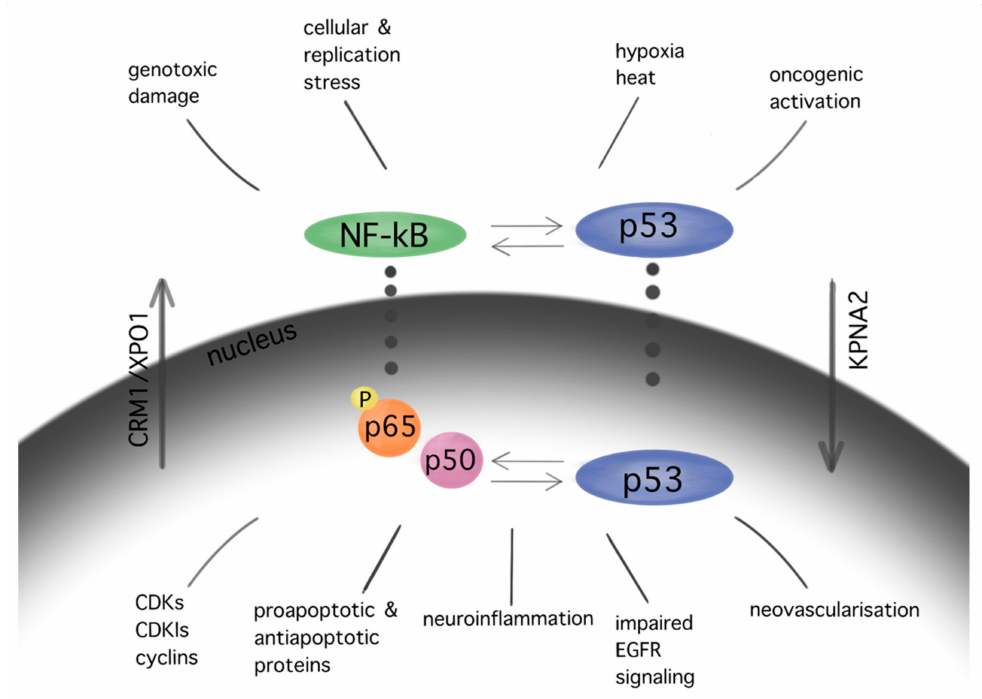
Figure 3. Interactions between pathways of p53 and NF-kB in GBM. Similar stimuli trigger NF-kB and p53 pathways. In turn, several interactions between the aforementioned cascades are observed in multiple levels at their cytoplasmic as well as their nuclear localization, resulting in cell cycle arrest, apoptosis, neuroinflammation, impaired EGFR signaling, and angiogenesis in GBM. The